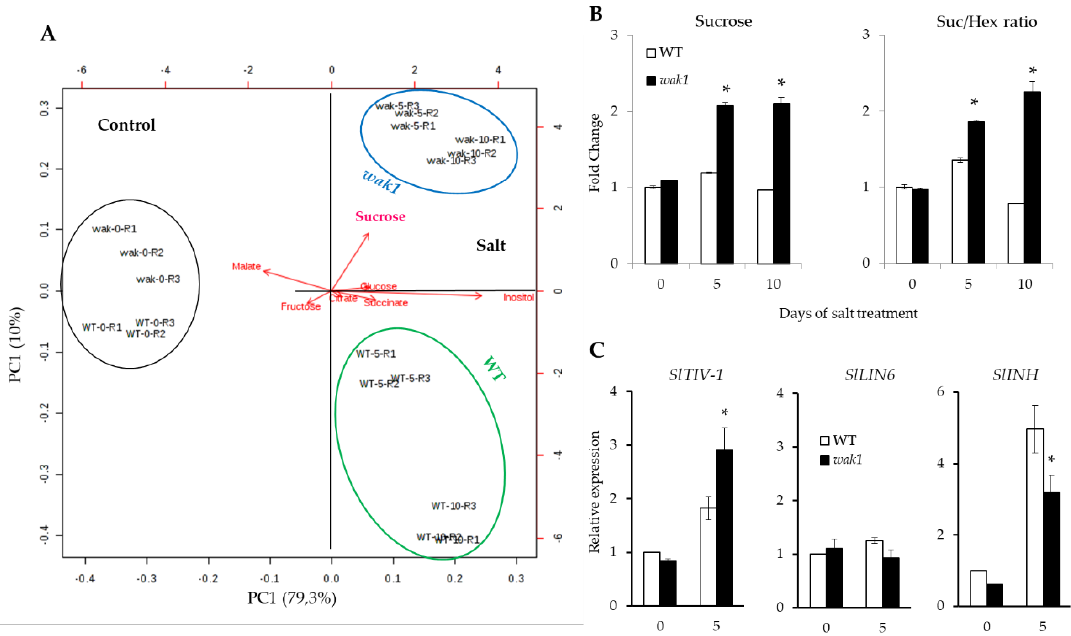
Figure 7. The disruption of SlWAK1 induces a high sucrose accumulation in root under salt stress. ( A ) PCA-biplot in roots of WT and Slwak1 plants grown at 0, 5 and 10 days of salt treatment (200 mM NaCl). Under salt stress, Slwak1 mutant is clearly separated from WT due mainly to sucrose contribution. ( B ) Fold changes of sucrose and sucrose/hexoses ratio in roots of WT and Slwak1 plants grown at 0, 5 and 10 days of salt treatment (200 mM NaCl). ( C ) Expression levels of key genes involved in sucrose cleavage into hexoses, the vacuolar invertase SlTIV-1 , the cell wall invertase SlLIN6 , and the invertase inhibitor SlINH , in roots of WT and Slwak1 plants grown at 0 and 5 days of salt treatment (200 mM NaCl). Data are expressed as mean ± SE ( n = 5). Asterisks indicate significant differences between mean values of WT and Slwak1 at the same organ (Student ’ s t -test, p < 0.05).